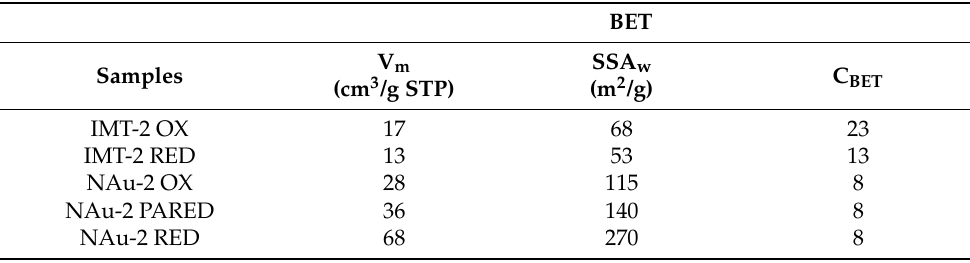
Table 1. BET Surface area and energetic constant from water vapour isotherms at 298 K; V m (cm 3/ g STP) is monolayer volume, S BET (m 2 /g) is the water specific surface area and C BET is the energetic constant of water. Error is estimated to be <5% for